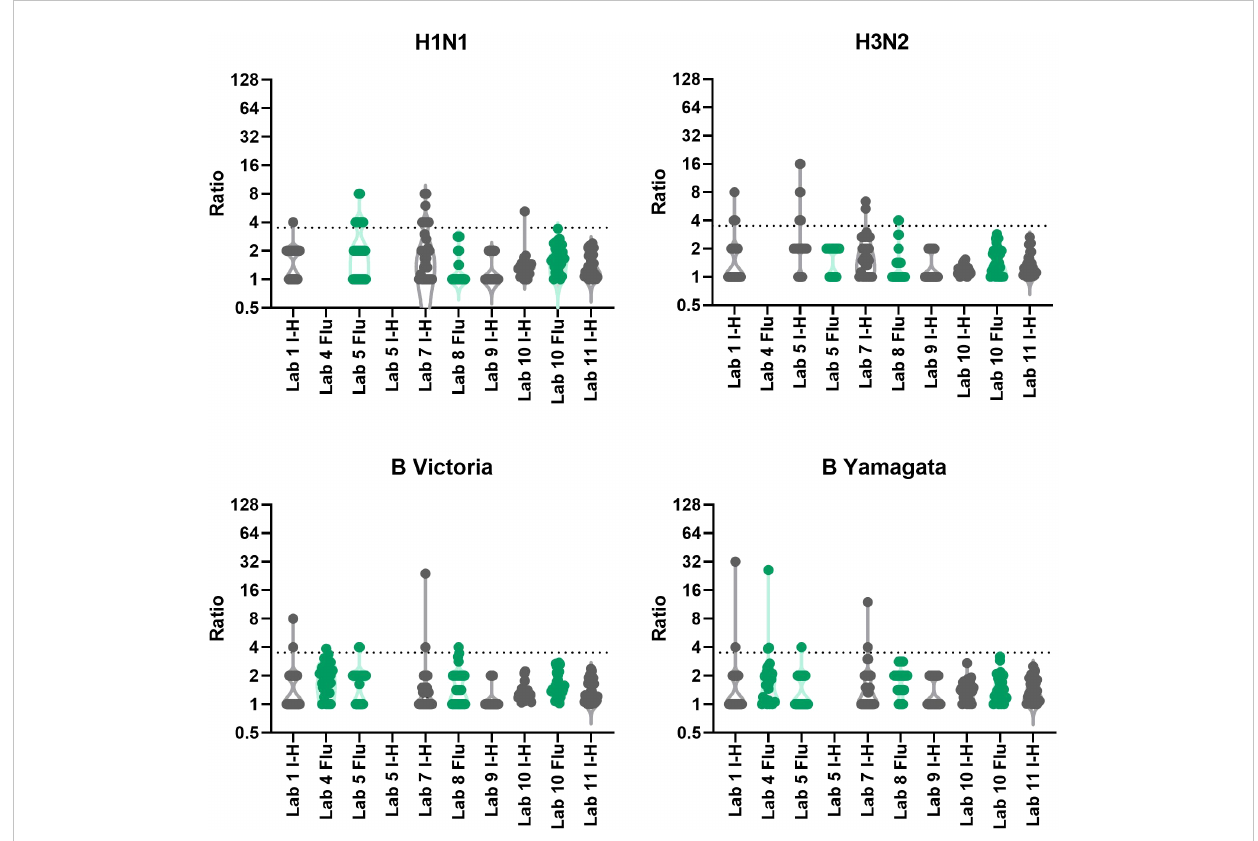
FIGURE 5 Intra-laboratory variability in MN testing. Maximum to minimum titre ratios for two-three independent MN replicates per laboratory. Dashed line represents the 3.5 cut-off for data exclusion for inter-laboratory variation analysis. Data in grey indicate in-house assays, data in green indicate FLUCOP